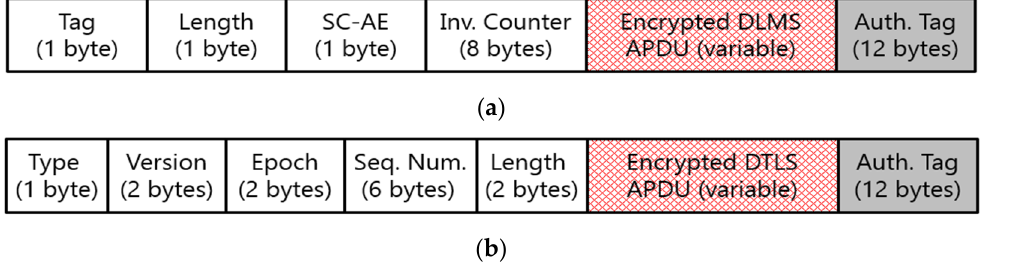
Figure 7. Ciphering APDU structure. ( a ) Structure of service-specific dedicated ciphering DLMS APDU [14]. ( b ) Structure of ciphering DTLS APDU [34].